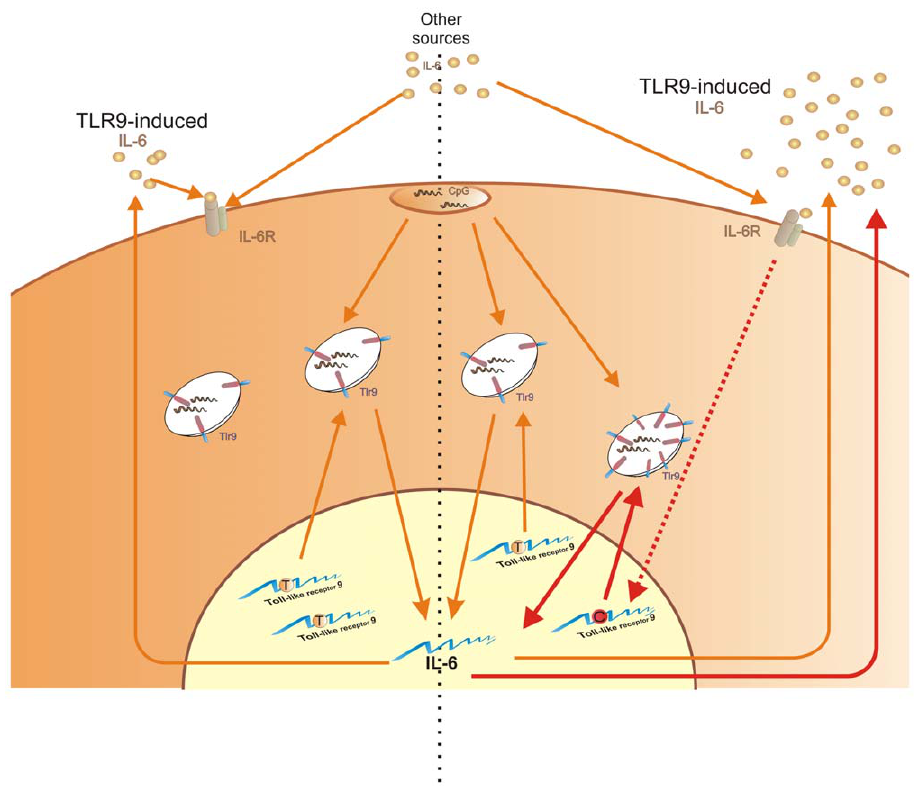
Figure 3. Proposed model of the effect of rs5743836 in B-lymphocyte activation and proliferation. TLR9 activation by CpG DNA induces the production of IL-6, which upon binding to its receptor, promotes translocation of STAT3 to the nucleus. This transcription factor can bind to and trans-activate promoters containing STAT3 binding elements, thus initiating a specific transcriptional program. In cells harboring the TC genotype of rs5743836, STAT3 will bind to a new IL-6 RE site, created by the T/C substitution within the TLR9 promoter. As a result, TLR9 expression increases in response to IL-6. Therefore, in these cells, a loop of TLR9/IL-6 signaling amplification is created, leading to a deregulation in B-cell activation and proliferation upon CpG stimuli. Of note, the IL-6 needed to generate this loop may be